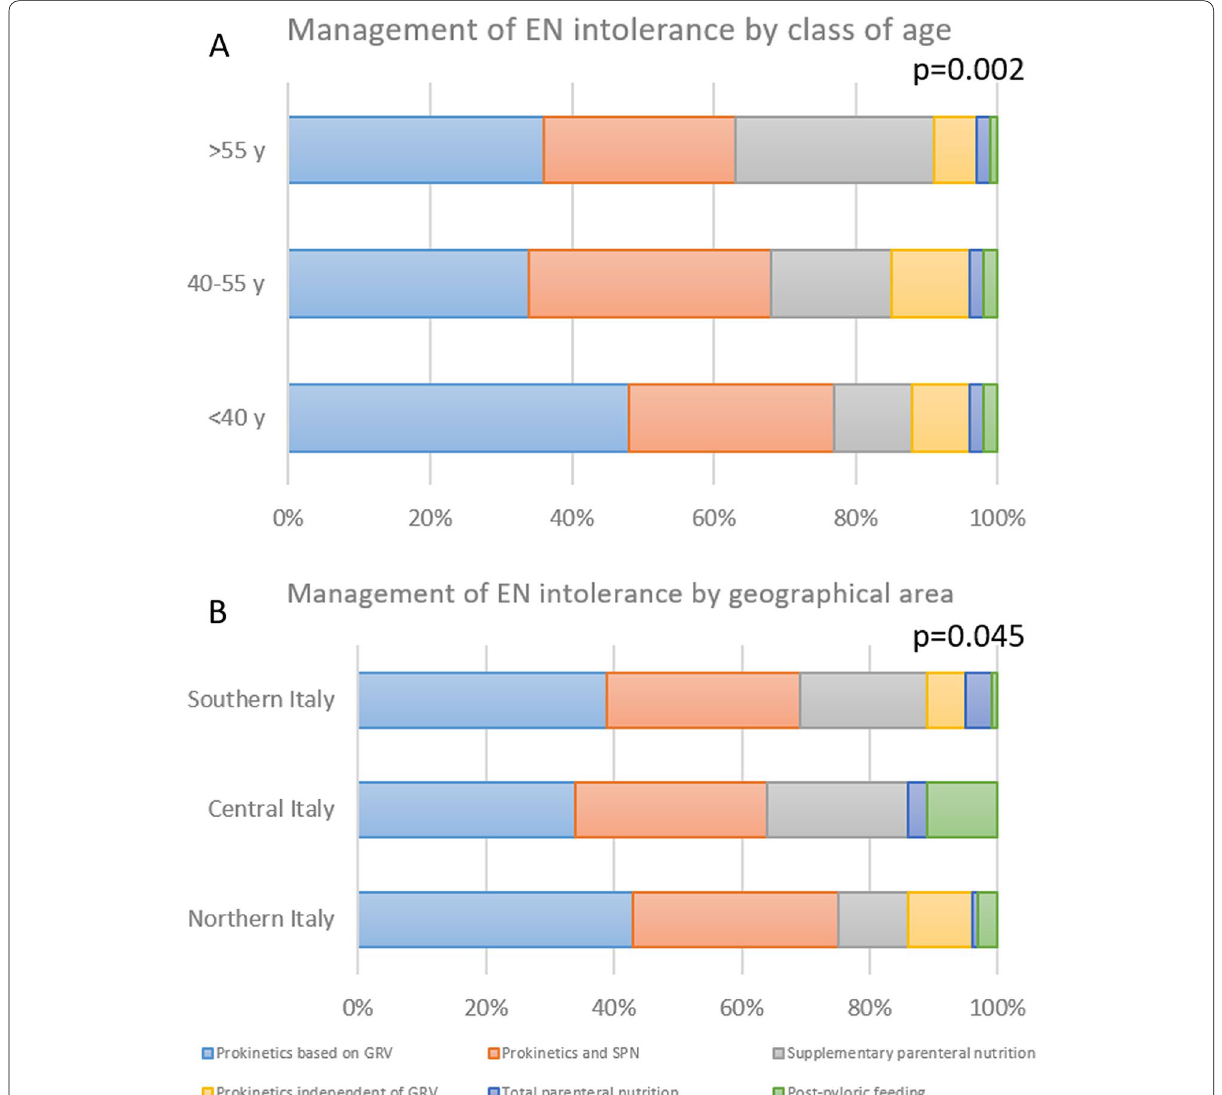
Fig. 4 Relationship between the strategies to overcome enteral nutrition intolerance and the class of age (upper) and geographical area (lower) of the